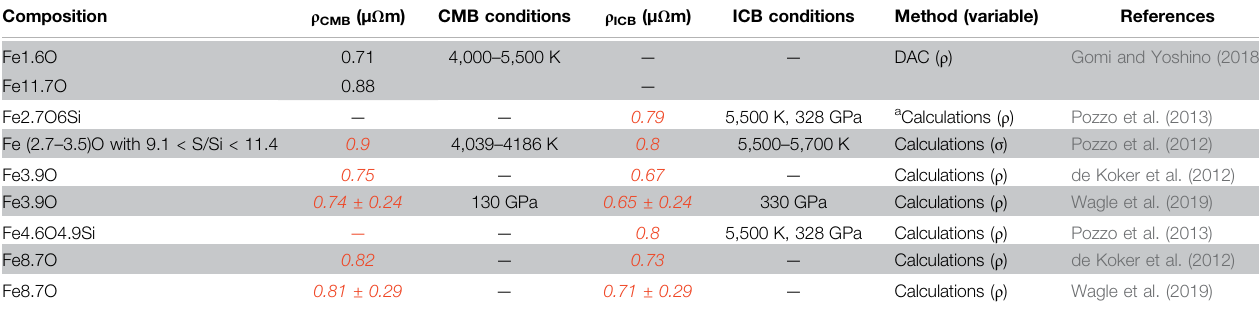
TABLE 3 | Electrical resistivity values of Fe-O alloys at Earth ’ s CMB (4,000 K, 136 GPa) and ICB (5000 K, 330 GPa) conditions determined by different methods. Composition